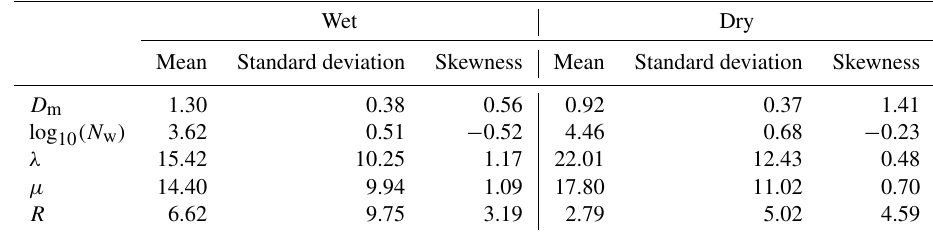
Table 3. Mean, standard deviation, and skewness of the DSD parameters in stratiform rain for wet and dry spells. Wet Dry Mean Standard deviation Skewness Mean Standard deviation Skewness D m 1.18 0.31